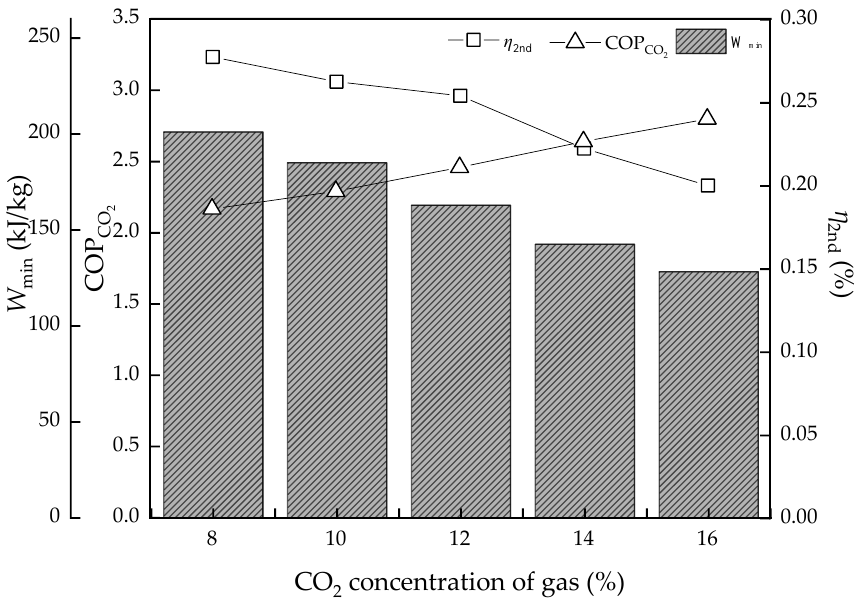
Figure 9. The energy efficiency performance with the CO 2 concentration variation.